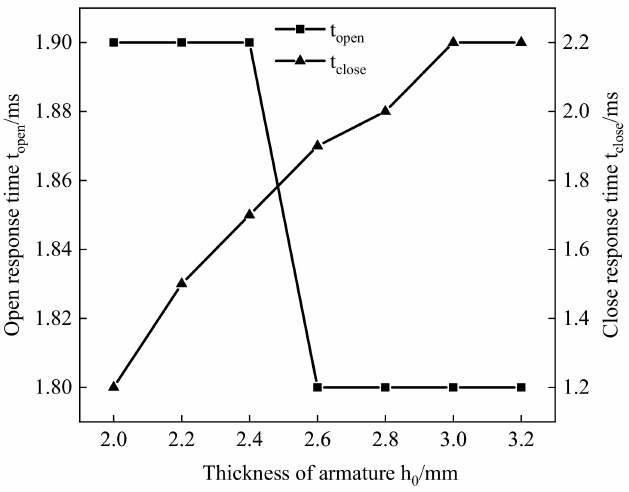
Figure 18. Effect of armature thickness h 0 on the dynamic response of the solenoid valve.